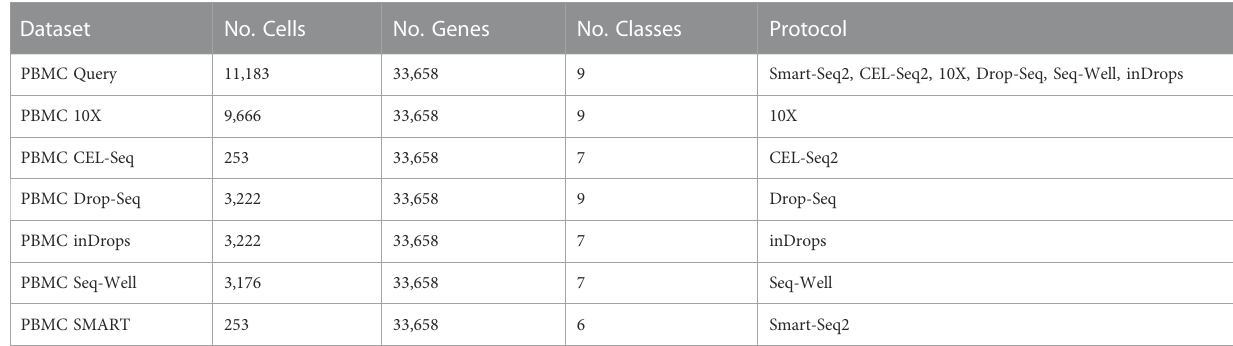
TABLE 1 Description of the PBMC datasets included in this study. Dataset